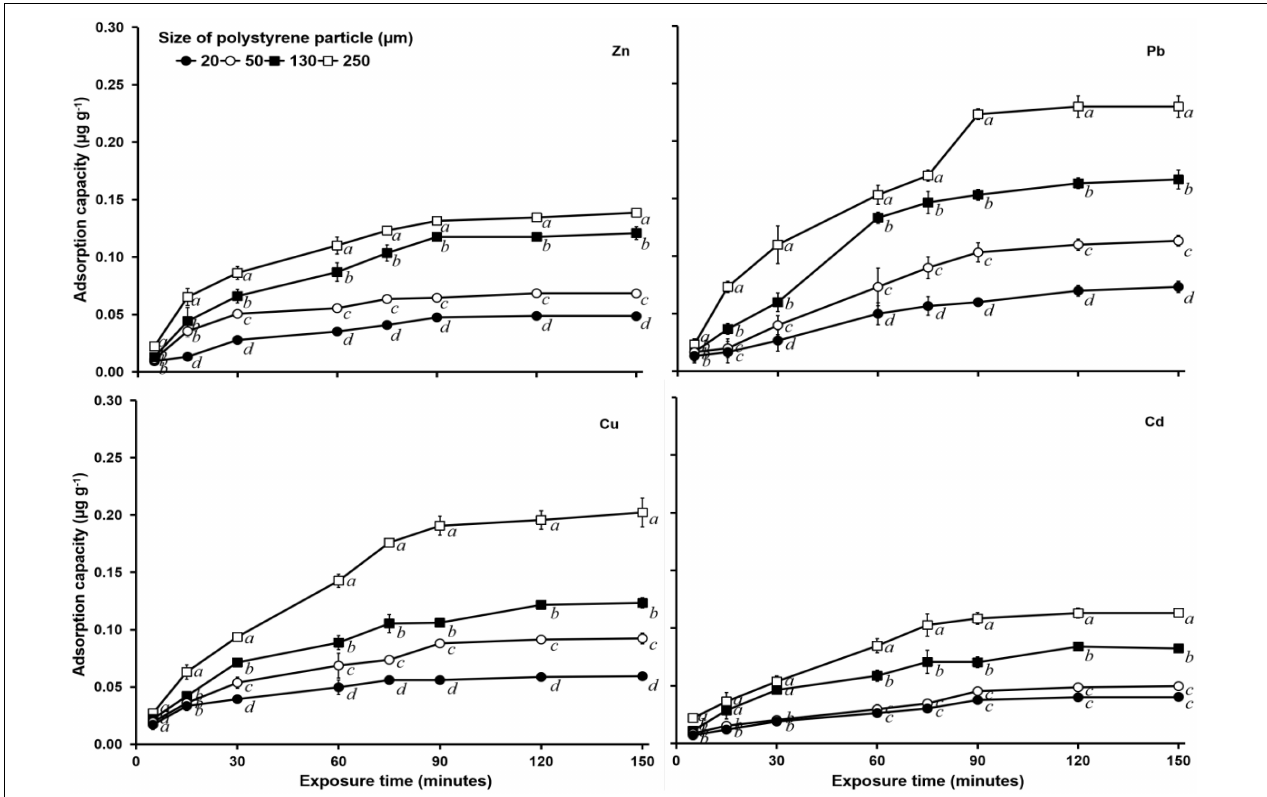
FIGURE 2 | Heavy metal (Zn, Pb, Cu, and Cd) adsorption capacity ( µ g g − 1 ) of PS of different sizes (20, 50, 130, and 250 µ m) with a 1 mg L − 1 heavy metal concentration and salinity of 15 . See Figure 1 for statistical (cid:104)